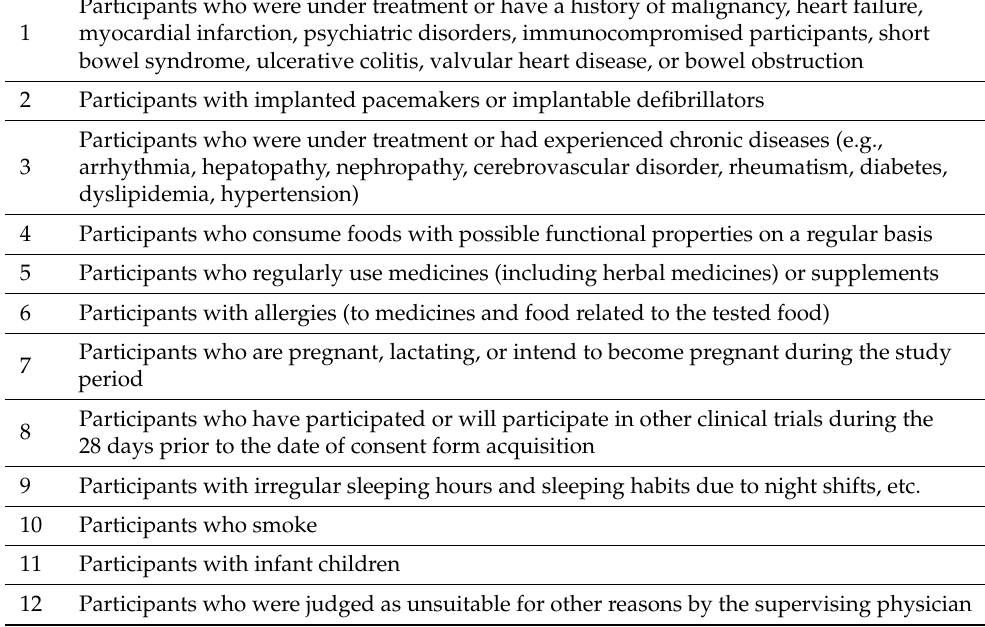
Table 1. Exclusion